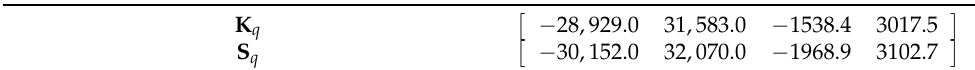
Table 5. Magnitudes of frequency responses for each controller (dB scale).